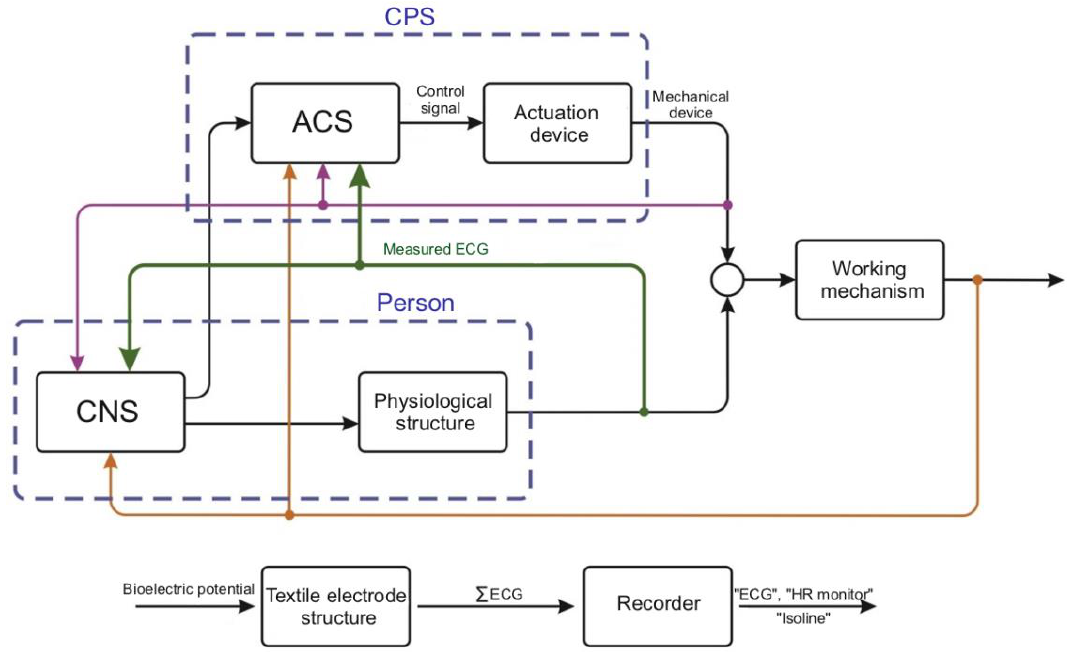
Figure 12. Block scheme of a biocybernetic system with an ECG link.